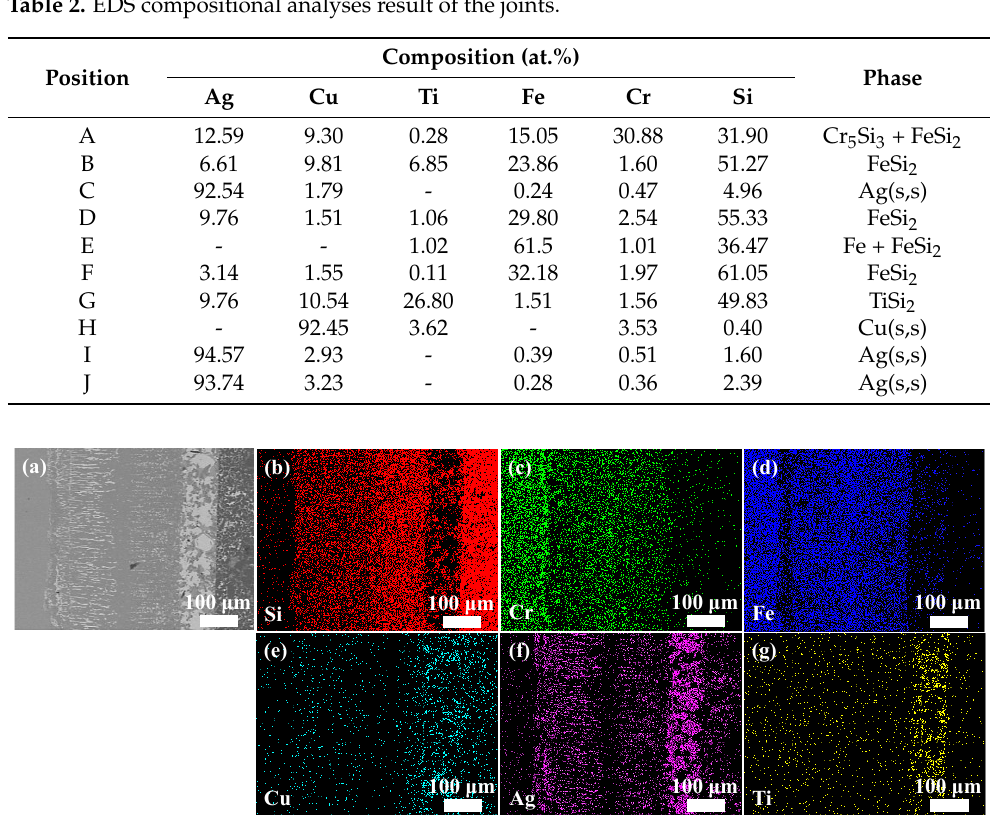
Figure 4. ( a ) The microstructure of the joint and the distribution of main elements in the joint; ( b ) Si; ( c ) Cr; ( d ) Fe; ( e ) Cu; ( f ) Ag; and ( g )